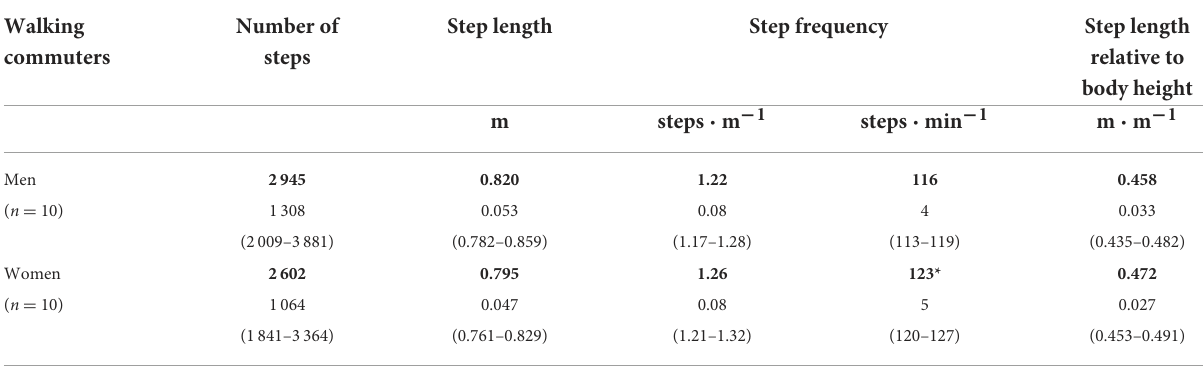
TABLE 6 Characteristics of steps and step frequency in walking commuting (mean, SD and 95% CI).